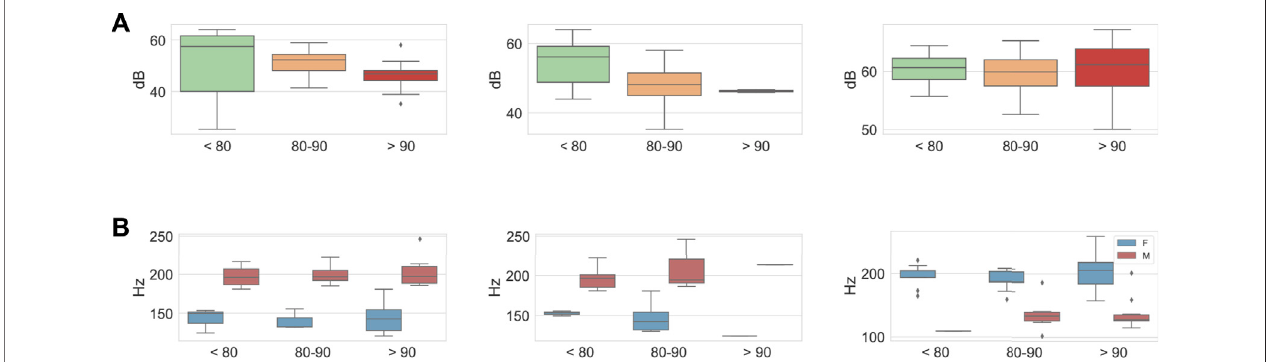
FIGURE 4 | Box plot representation of extracted intensity (dB), and pitch ( F 0 ) of each speaker. Grouped based on μ Heart Rate as BPM. Including, REG-TSST interview task, REG-TSST arithmetic task, and ULM-TSST interview task. (A) Intensity dB — R EG -TSST, Interview and Arithmetic, U LM -TSST Interview. (B) F 0 Hz — R EG -TSST, Interview and Arithmetic, U LM -TSST